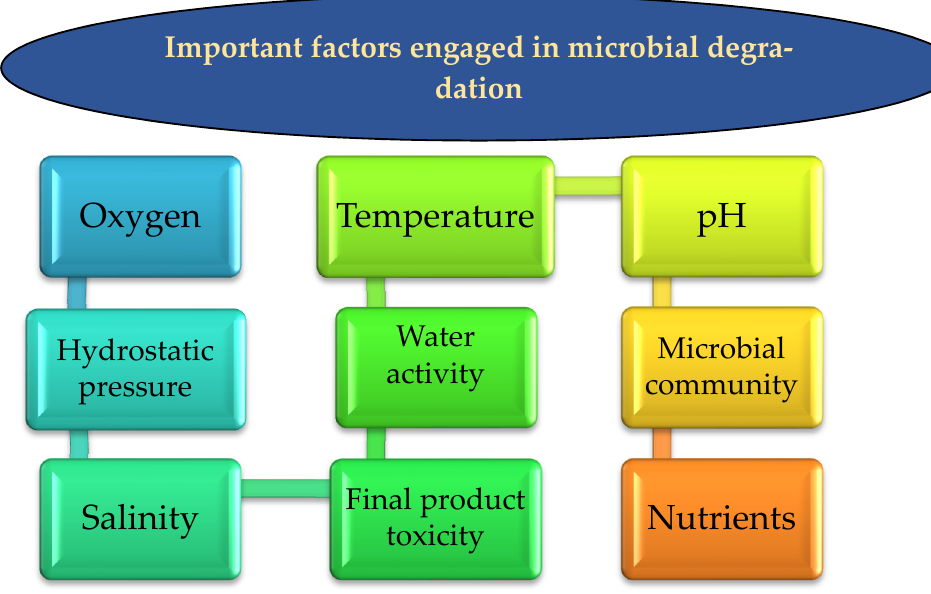
Figure 2. The most important factors impacting biodegradation by microorganisms.